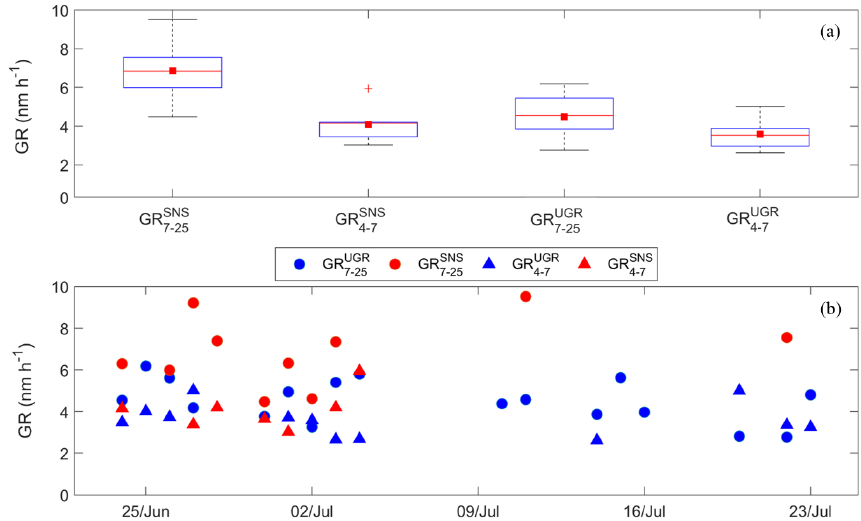
Figure 4. (a) Box and whisker plot of growth rates recorded at the SNS and UGR stations. The red line represents the median of the data, the square represents the mean of the data, and the lower and upper edges of the box represent the 25th and 75th percentiles of the data, respectively. The length of the whiskers represents the 1 . 5 × interquartile range, which includes 99.3% of the data. (b) Growth rate time series at the SNS and UGR station.